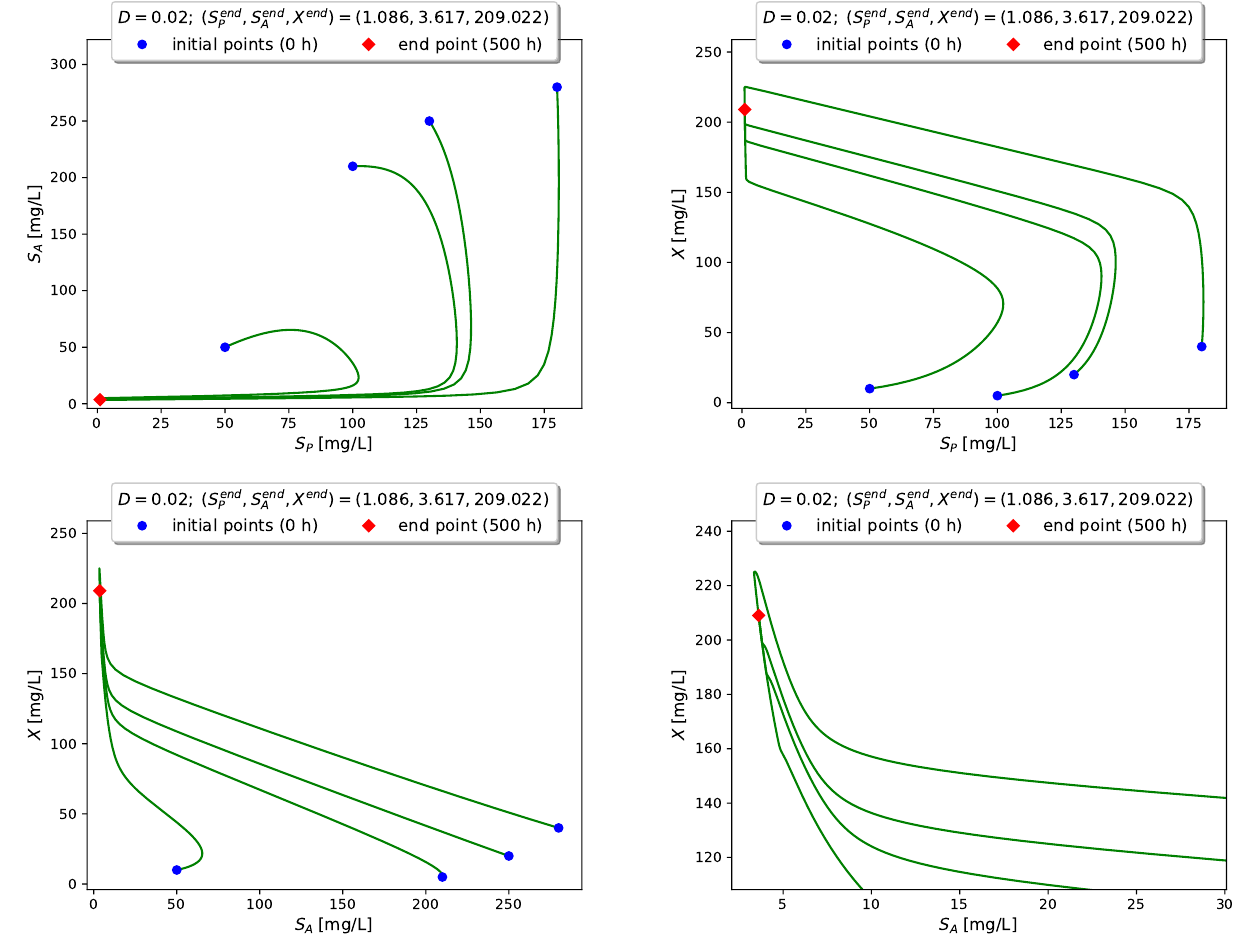
Figure 6. Example 2. Projection of trajectories of system (1)–(3) in different phase planes with several initial conditions. The right plot below presents an enlarged fragment of the left one in a neighborhood of the equilibrium components ( S ∗ , X ∗ ) . A